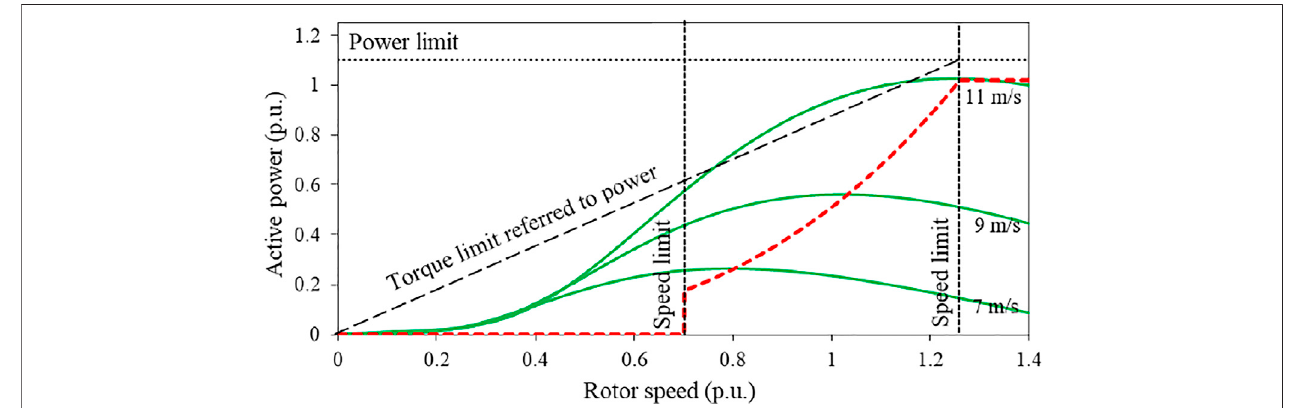
FIGURE 9 | Power characteristics of the doubly-fed induction generator (DFIG) used in this study.